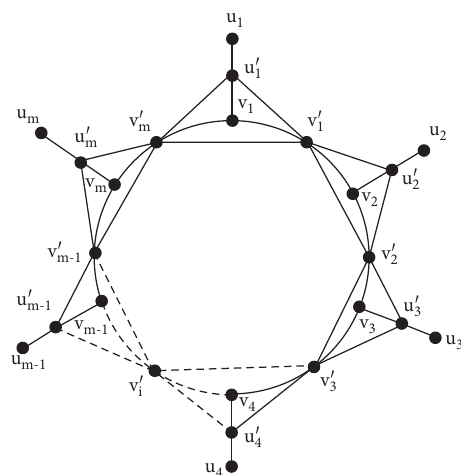
Figure 2: Middle sunlet network MS